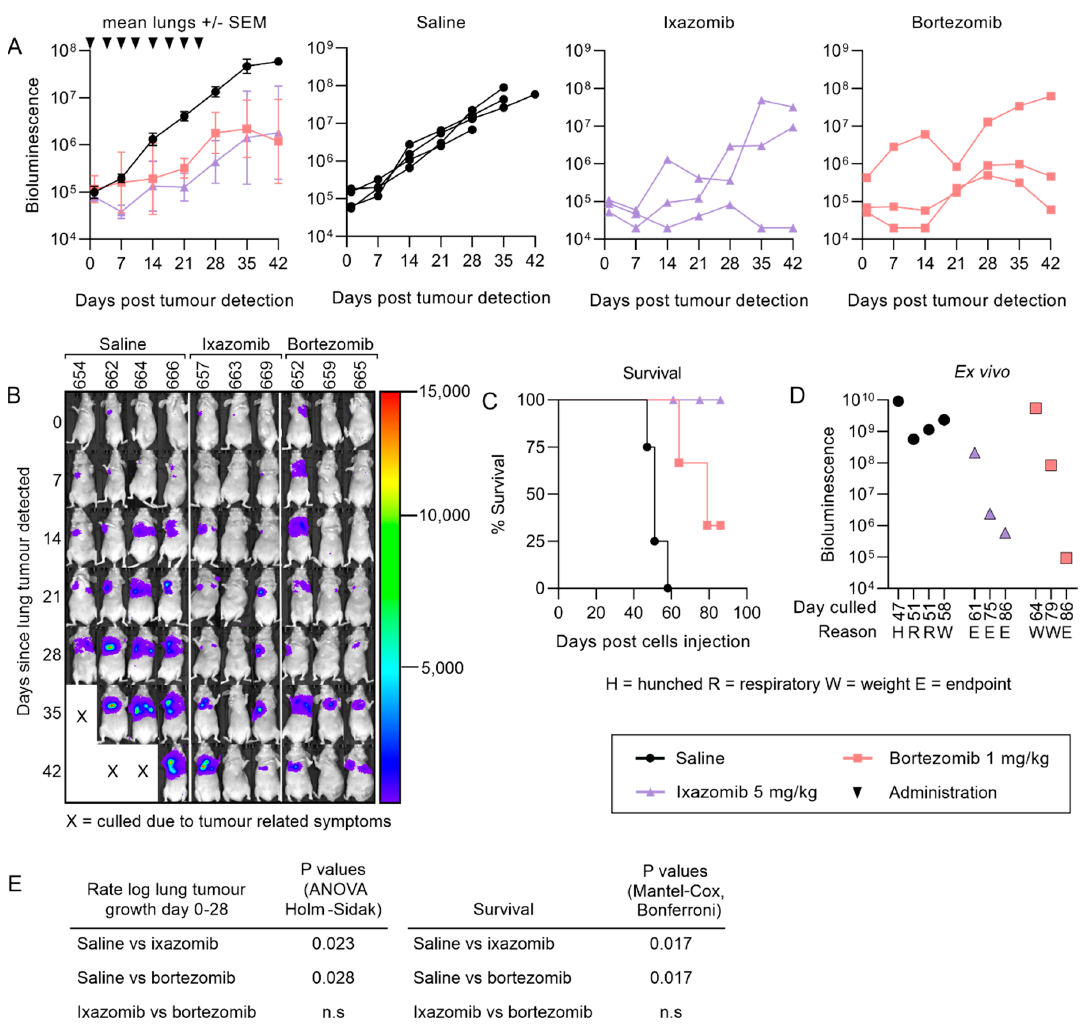
Figure 3. Ixazomib and bortezomib inhibit the growth of KRIB-luc pulmonary metastases and survival is enhanced in ixazomib treated mice compared to mice treated with saline. Mice were injected with KRIB-luc cells intravenously and alternately allocated to different treatment groups as lung tumors were detected and subsequently treated for four weeks ( A ). Compiled images of bioluminescence representing tumor growth starting from the day the tumor was detected until the endpoint of the experiment ( B) . A Kaplan Meier curve was used to compare survival times between treatment groups ( C ). Lungs were removed from the mice when tumor related symptoms required the mouse to be euthanized or at the endpoint of the experiment and imaged ex vivo to compare endpoint tumor burden in the lungs ( D ). Rates of growth of tumors and survival between treatment groups were compared ( E ). (n = 4 for saline and 3 for ixazomib and bortezomib, +/ − SEM).